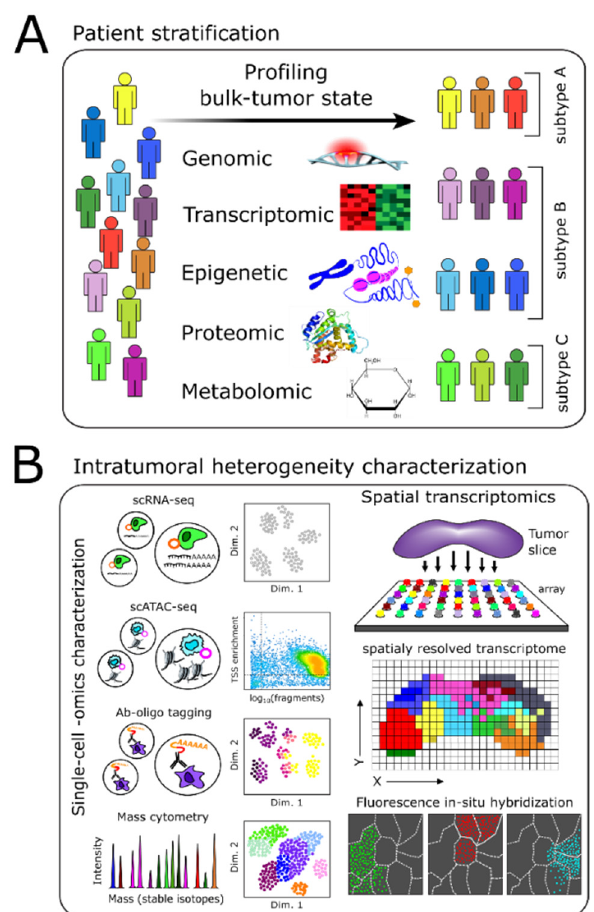
Figure 1. Multi-level characterization of tumors. The convergence of technological advances and existing knowledge of brain tumor biology create an opportunity in which systems approaches can integrate technologies to stratify patients and characterize brain tumors precisely. ( A ) Multi-omic characterization of brain tumors is necessary to stratify patients into biologically and clinically meaningful cohorts that may be more amenable to certain treatments. ( B ) Intratumoral heterogeneity is a major challenge that hinders effective therapy. Multi-omic, single-cell-level characterization on the transcriptomic, epigenetic, and proteomic level is necessary to identify appropriately the various tumor-cell subpopulations and associated molecular vulnerabilities. In addition, spatial transcriptomic technologies provide the ability to measure tumor structure directly, which is lost due to tissue dissociation during sample preparation for single-cell technologies such as scRNA-seq or scATAC-seq.